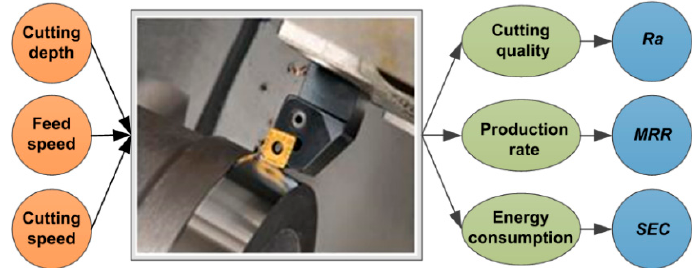
Figure 1. Multi-objective optimization framework of turning parameters.